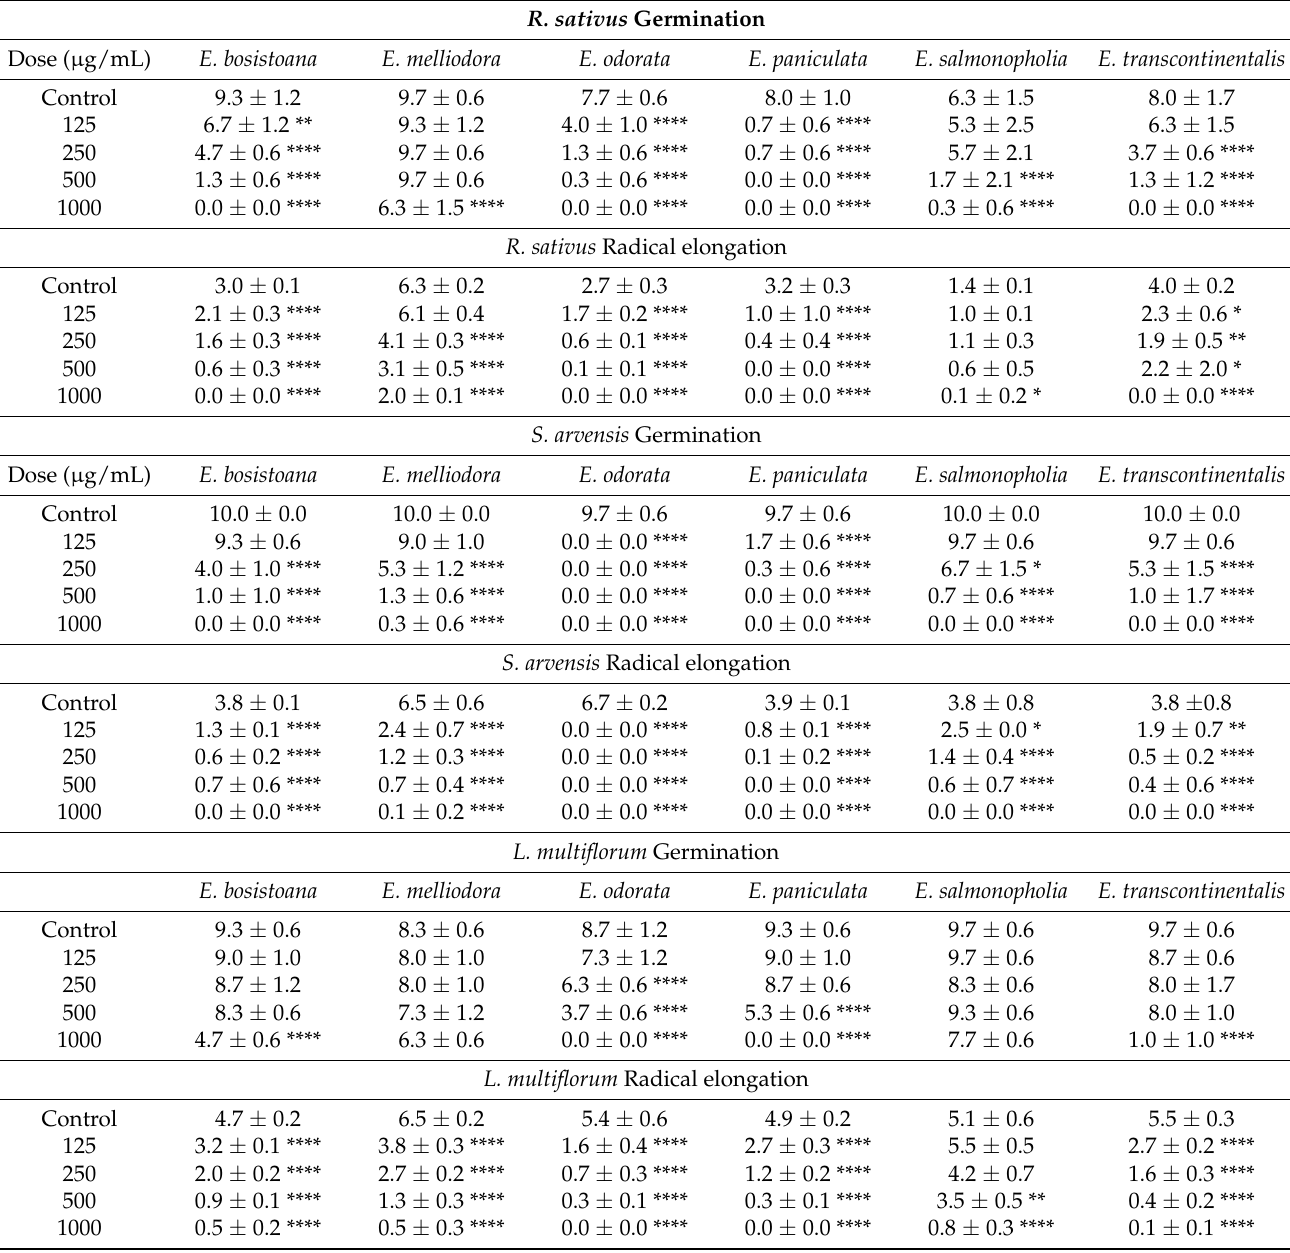
Table 2. Effects of different doses of the EOs on germination (number of germinated seeds) and radical elongation (cm) of Raphanus sativus , Sinapis arvensis and Lolium multiflorum